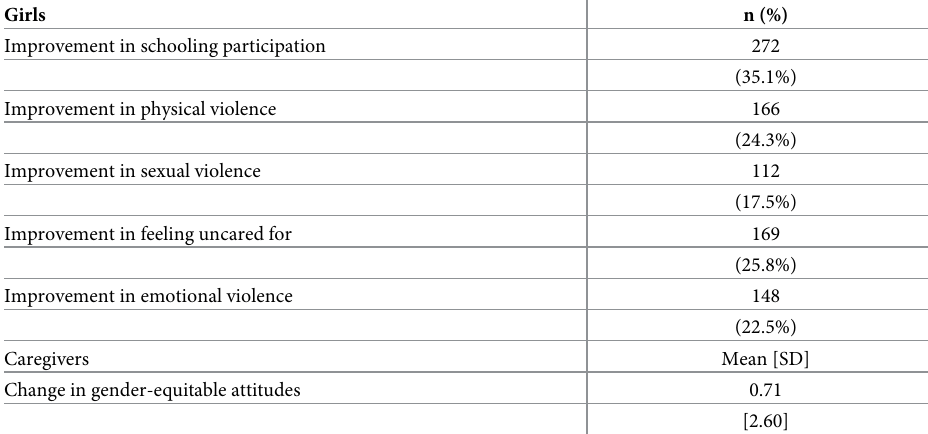
Table 2. Changes between baseline and